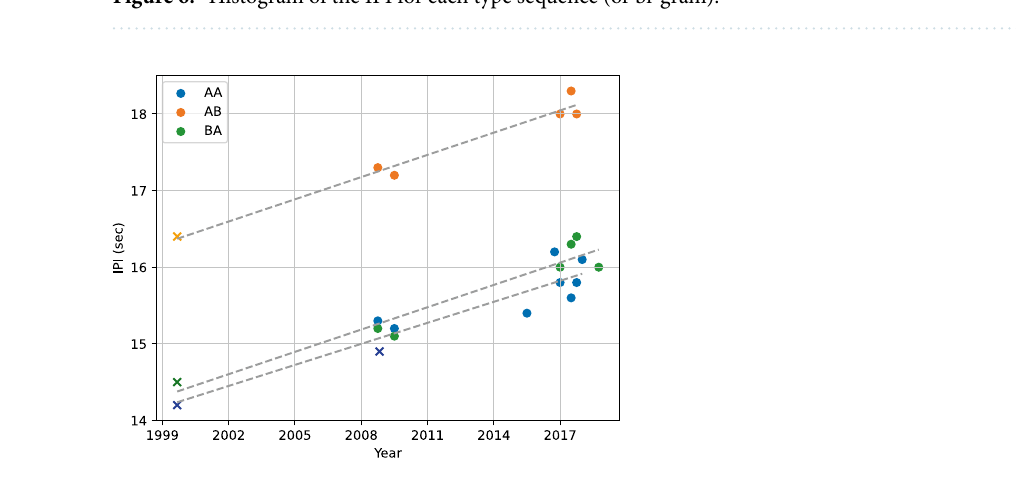
Figure 7. Scatter plot of the most frequent IPI per trimester for each type sequence. Fitted linear models are shown as grey dashed lines. Points extracted from Clark et al. 18 and Castellote et al. 12 appear as